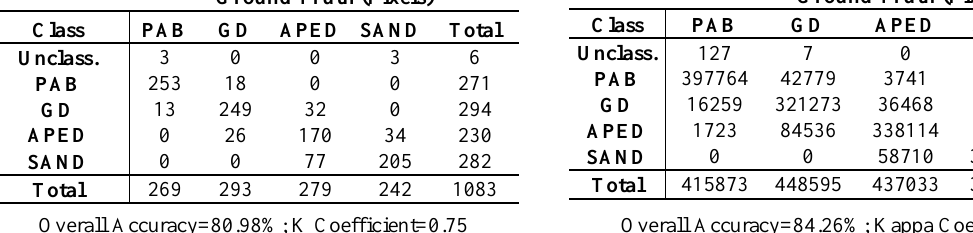
Table 4. Confusion matrix concerning the object-based classification: Worldview-2 data (a) and UAV Orthophoto (b). From the spatial error distribution point of view, the zones affected by error are modest compared to the overall study area and to the pixel classification of UAV orthophoto. As already boundaries between the classes.